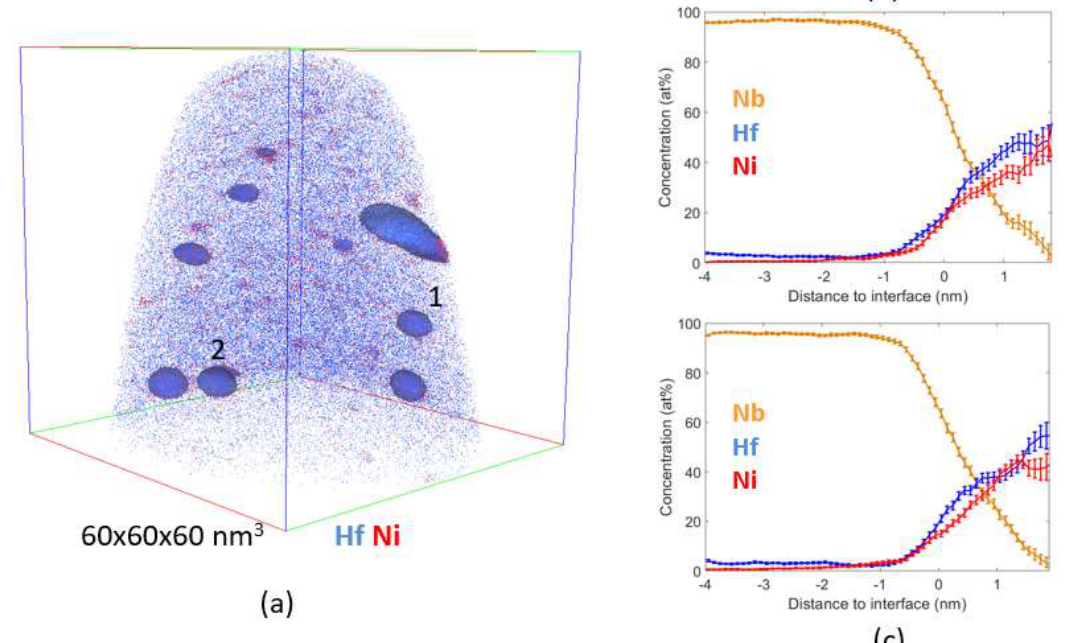
Figure 7. ( a ) Reconstruction of Figure 6b wherein isosurfaces were displayed for a concentration of Hf equal to 19%. This value was set empirically in order to allow the calculation of concentration profiles across these interfaces. ( b ) and ( c ) correspond respectively to the proximity histogram calculated along interfaces for precipitate 1 and 2 as shown in ( a ). In ( b ) and ( c ), the precipitate is on the left and the matrix on the right. The Hf/Ni relative concentration within the precipitates is comprised between 60/40 and 50/50.